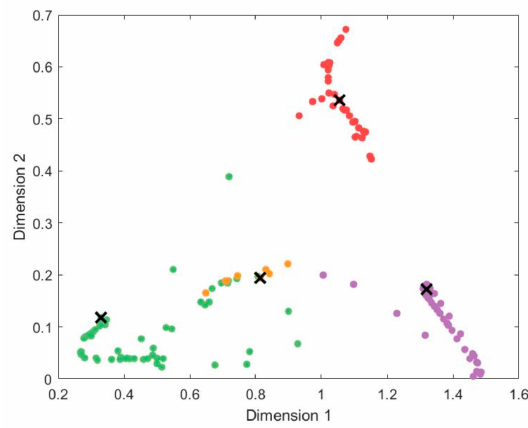
Figure 4. Example of dividing 4 subspaces by